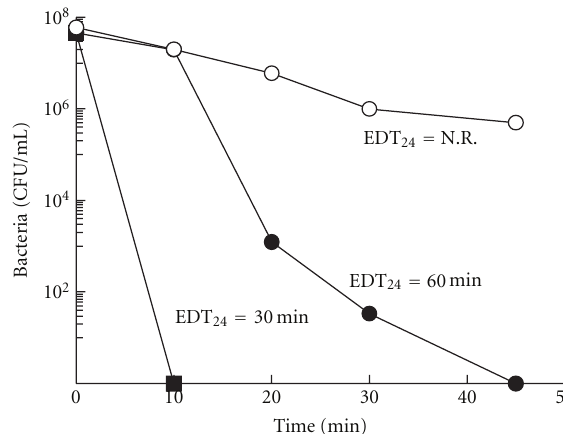
Figure 10: Photocatalytic water disinfection using ( ) Ag(2)TiO 2 , and ( (cid:4) ) TiO 2 samples, under 9.8 W/m 2 of natural ( (cid:0) sunshine light irradiation of interior